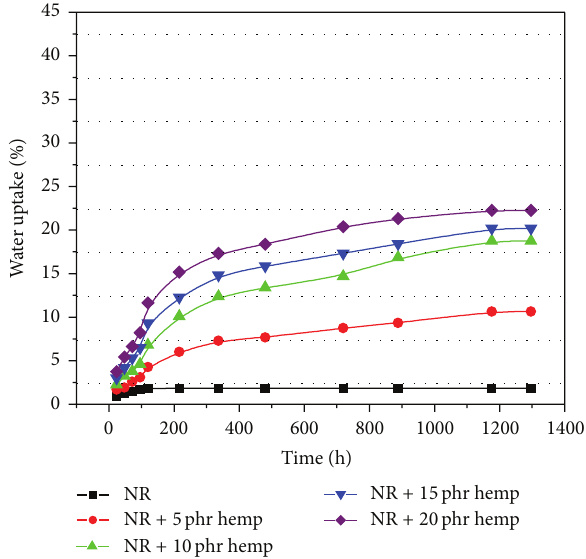
Figure 10: Water uptake of polymeric composites at absorbed dose of 600